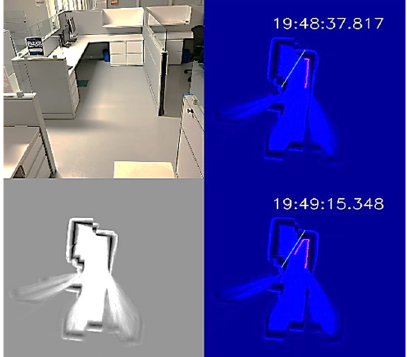
Figure 12. UVBot disinfection test in an office cell using a virtual wall. Top-left : Photo of the office cell; bottom-left : the stored map; top-right and bottom-right : UVBot disinfection map with the virtual wall.